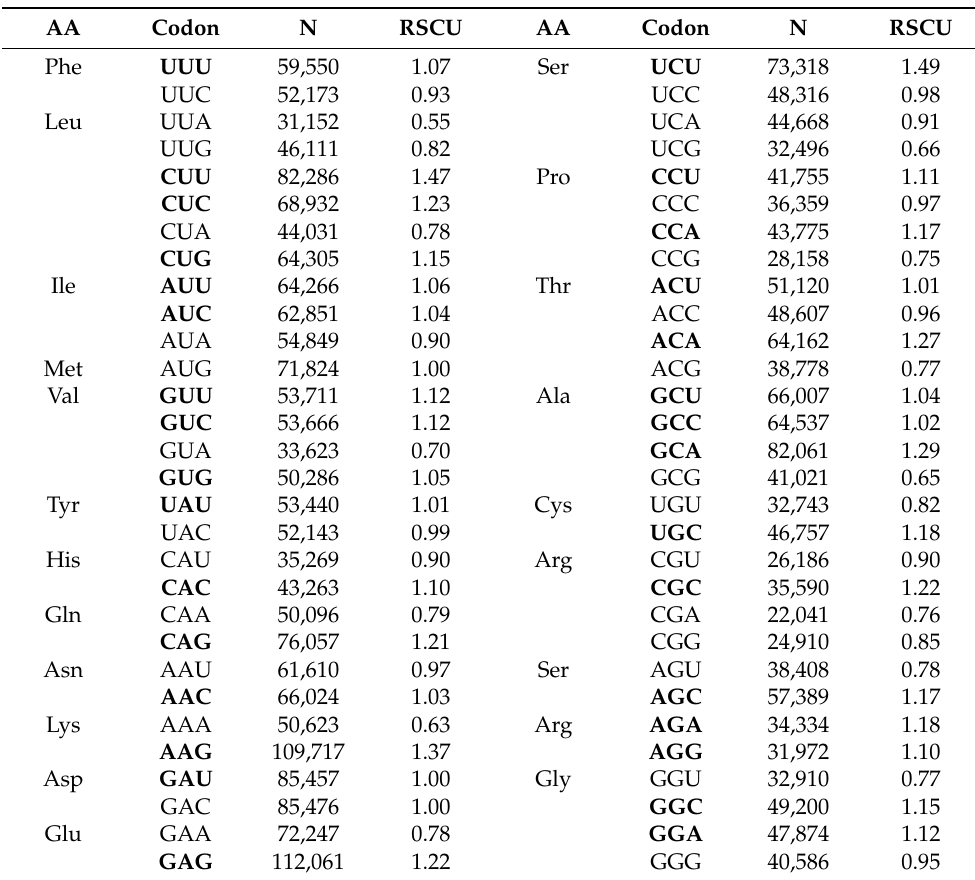
Table 1. Codon usage in G. duodenalis .